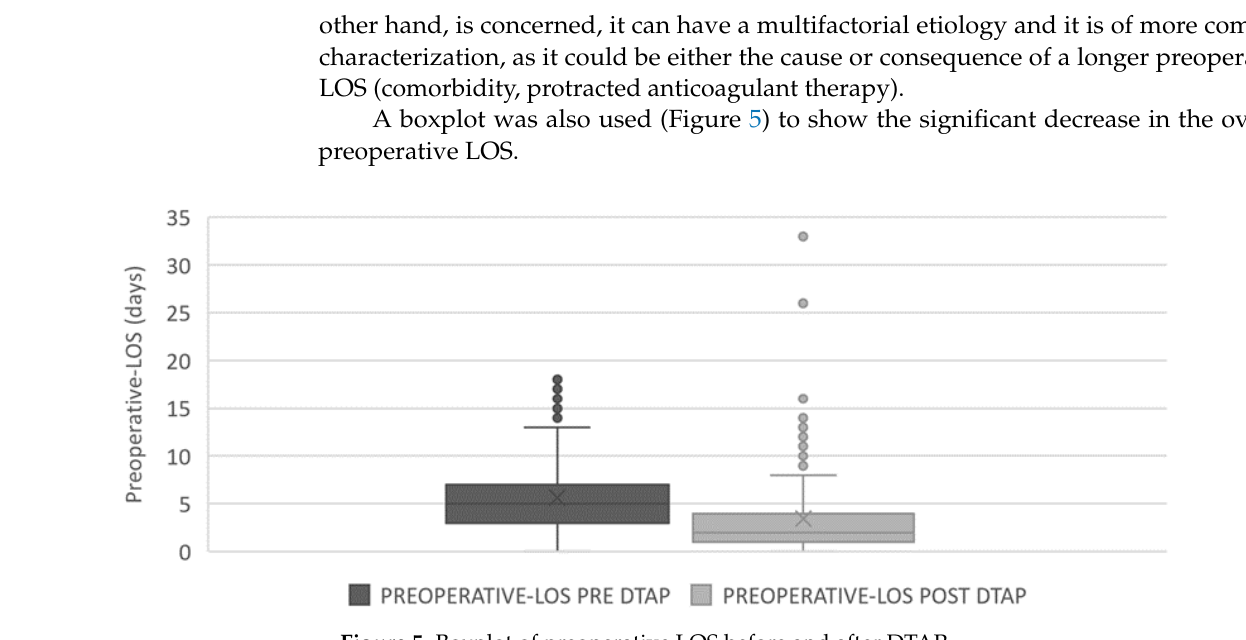
Table 4. Comparison of the results achieved by implementing DTAP for femur fracture in analo- gous literature works.